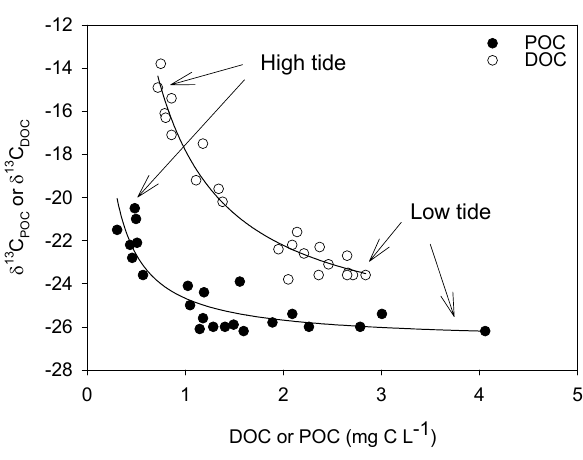
Fig. 6. Concentrations and δ 13 C signatures of particulate and dis- solved organic carbon (dark and open symbols, respectively) during a diurnal cycle. Lines represent a fitted inverse first order polyno- mial, of the form y = y 0 + a/x , with y 0 = − 26.6 ± 0.3 for DOC and − 26.7 ± 0.3 (1S.E.) for POC (see text for